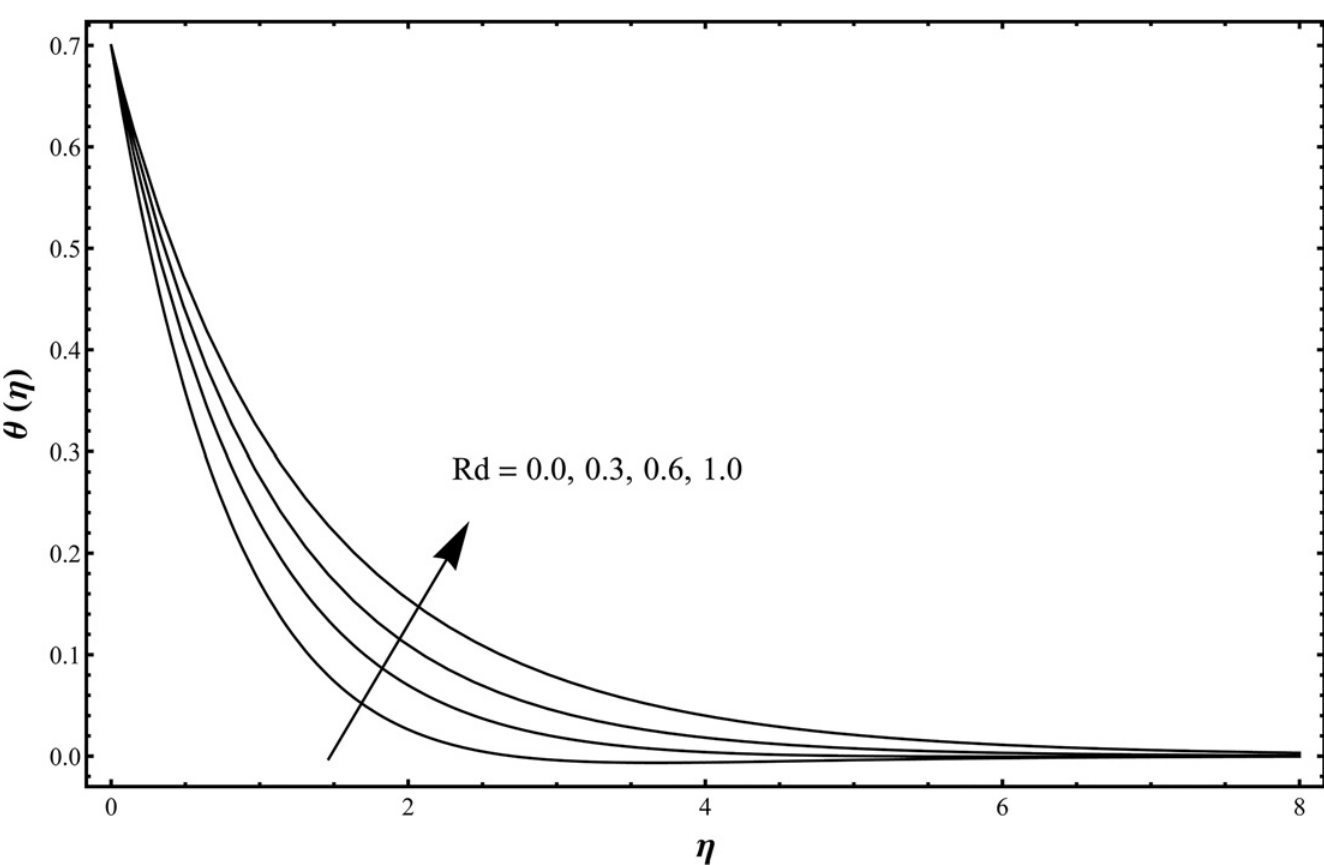
Fig 7. Temperature distribution function θ ( η ) when Rd = 0.0, 0.3, 0.6, 1.0 and β 1 = β 2 = 0.2 = γ , λ = 0.1 = N , Pr = 1.0 = Sc , ε 1 = 0.3 = ε 2